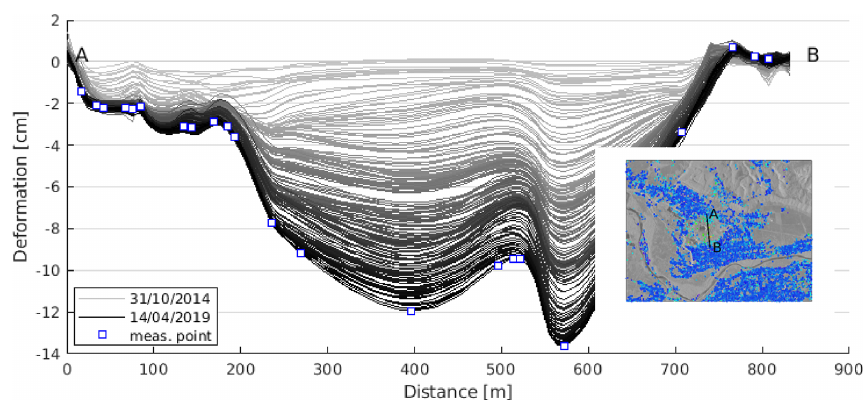
Figure 9. Temporal evolution of LOS surface deformation for the A–B cross section from ascending Sentinel-1 data. For the location of the section see the insert. The shade of gray varies from light to dark as time advances (lightest: October 2014, darkest: April 2019); blue squares show location of InSAR observations along the profile.